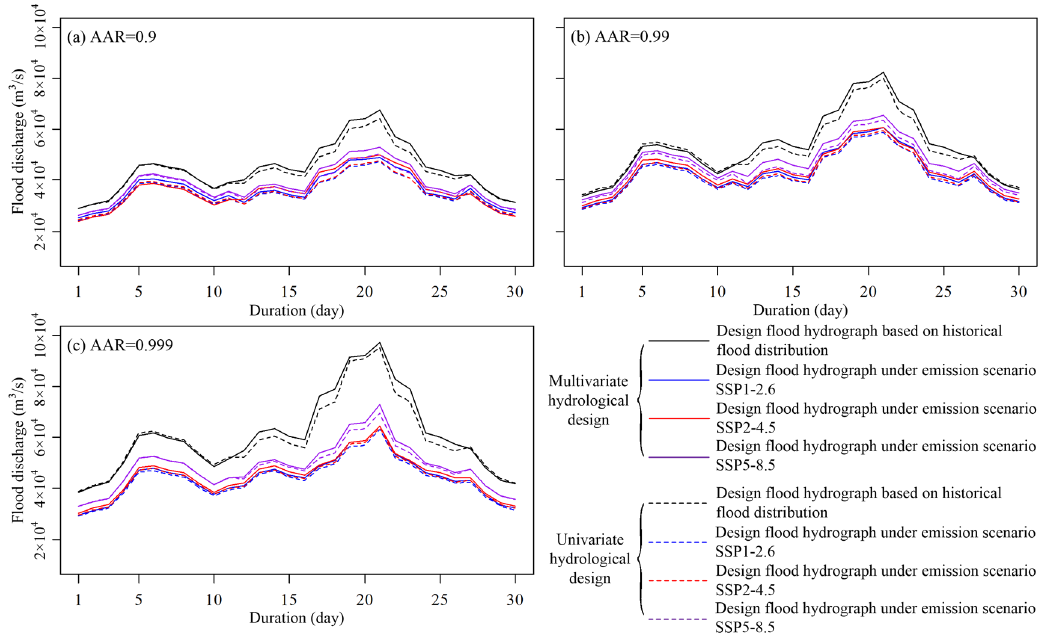
Figure 6. Dam-site design hydrographs associated with OR exceedance probability for the TGR. Panels ( a ), ( b ) and ( c ) display the results for design levels with the AARs of 0.9, 0.99 and 0.999, respectively.